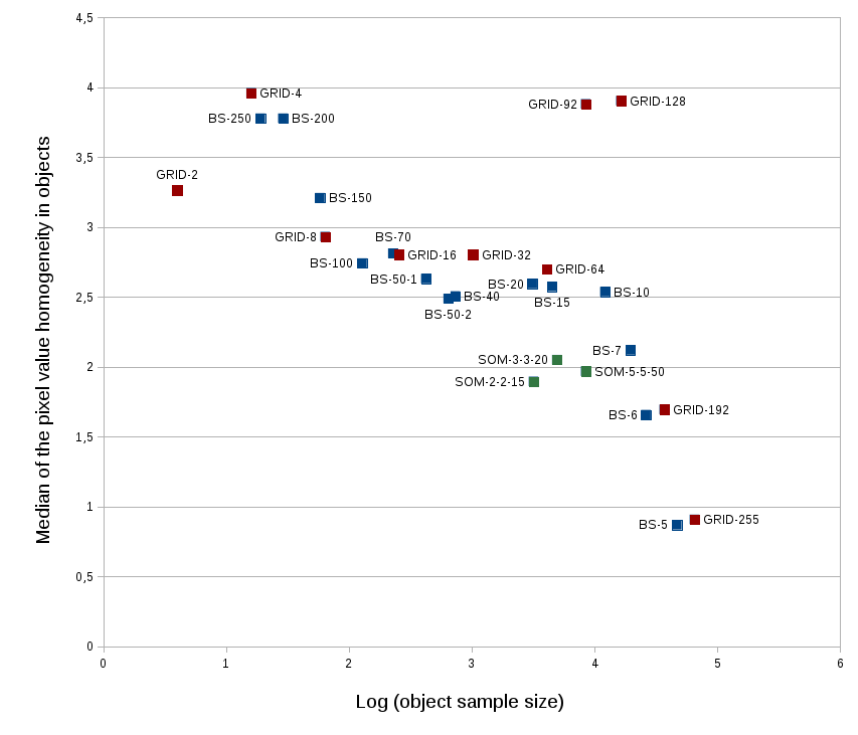
Figure 15. Median of the pixel value homogeneity in objects.